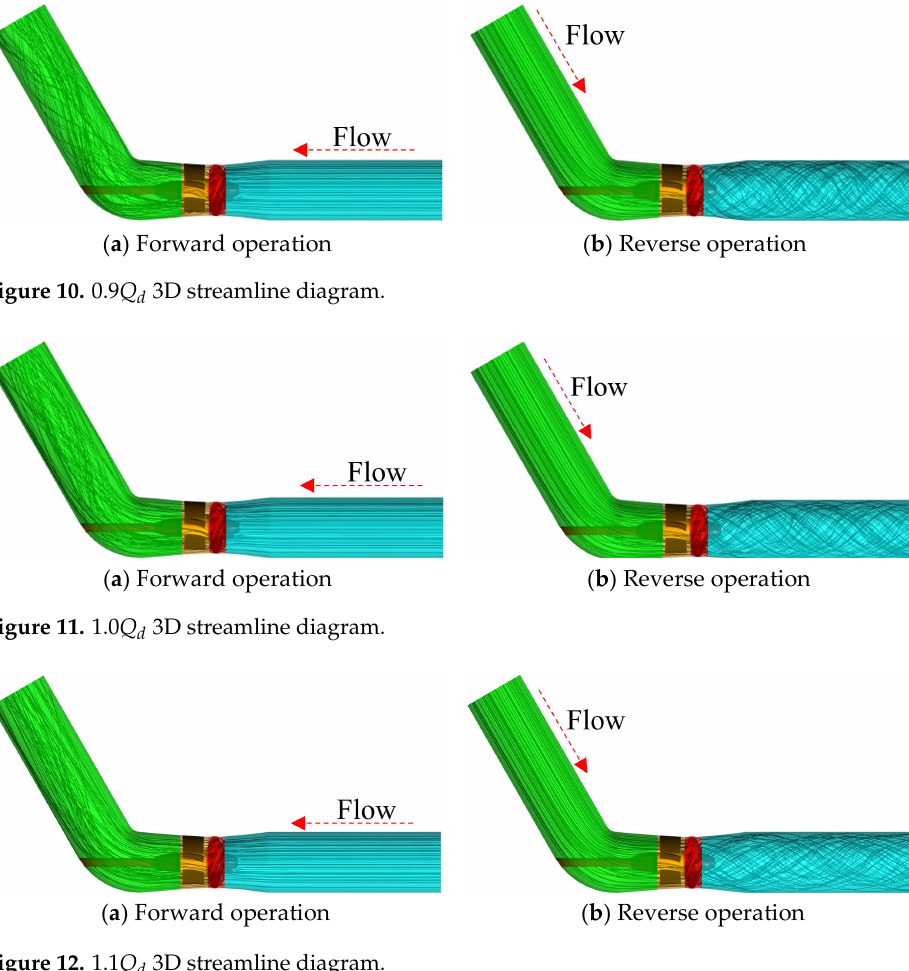
( b ) Reverse operation Figure 13. 0.9 Q d clouds of total pressure distribution in the middle cross section.